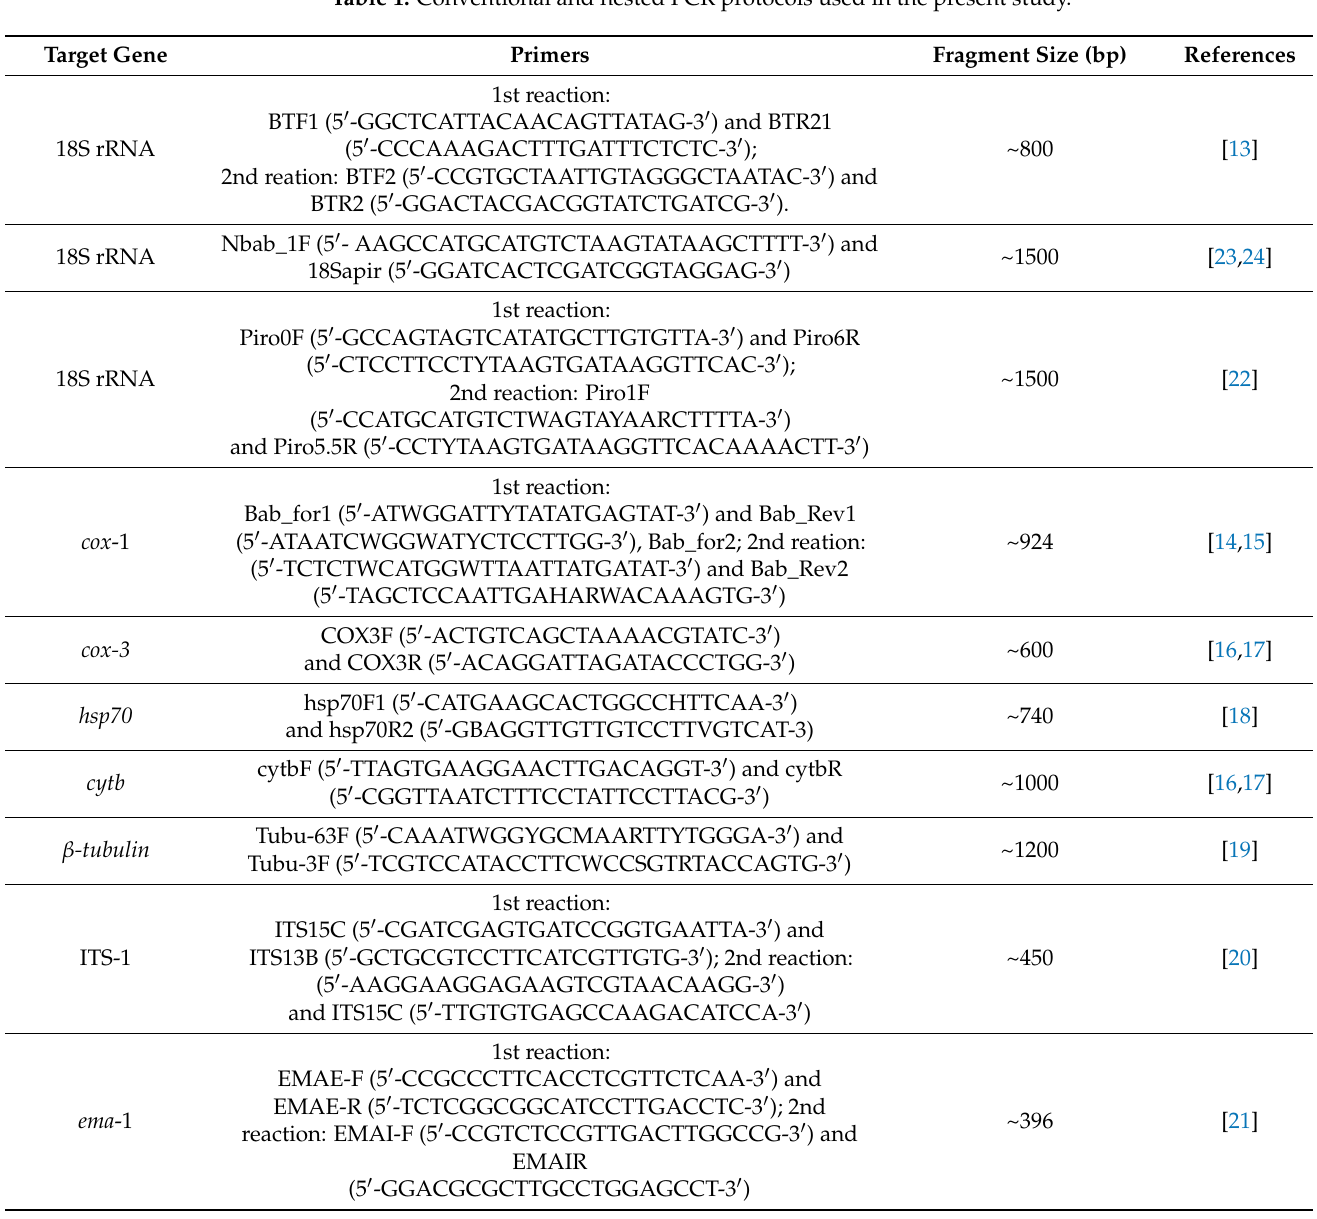
Table 1. Conventional and nested PCR protocols used in the present study. Target Gene Primers Fragment Size